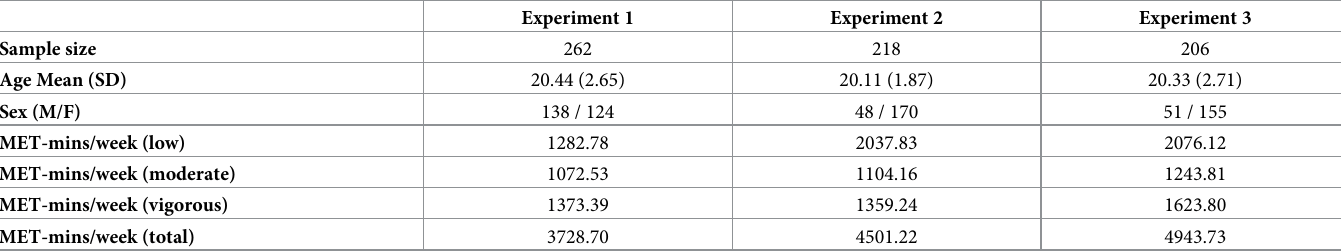
Table 1. Participant characteristics for all three